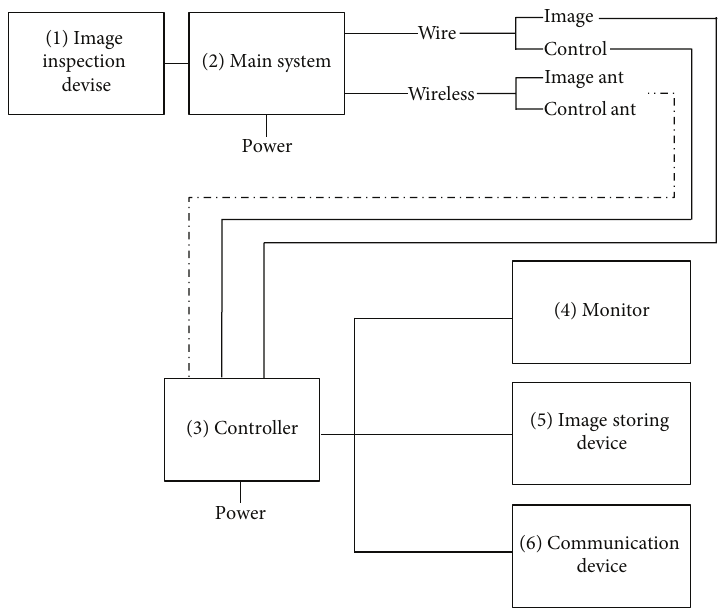
Figure 4: Configuration of the proposed system.